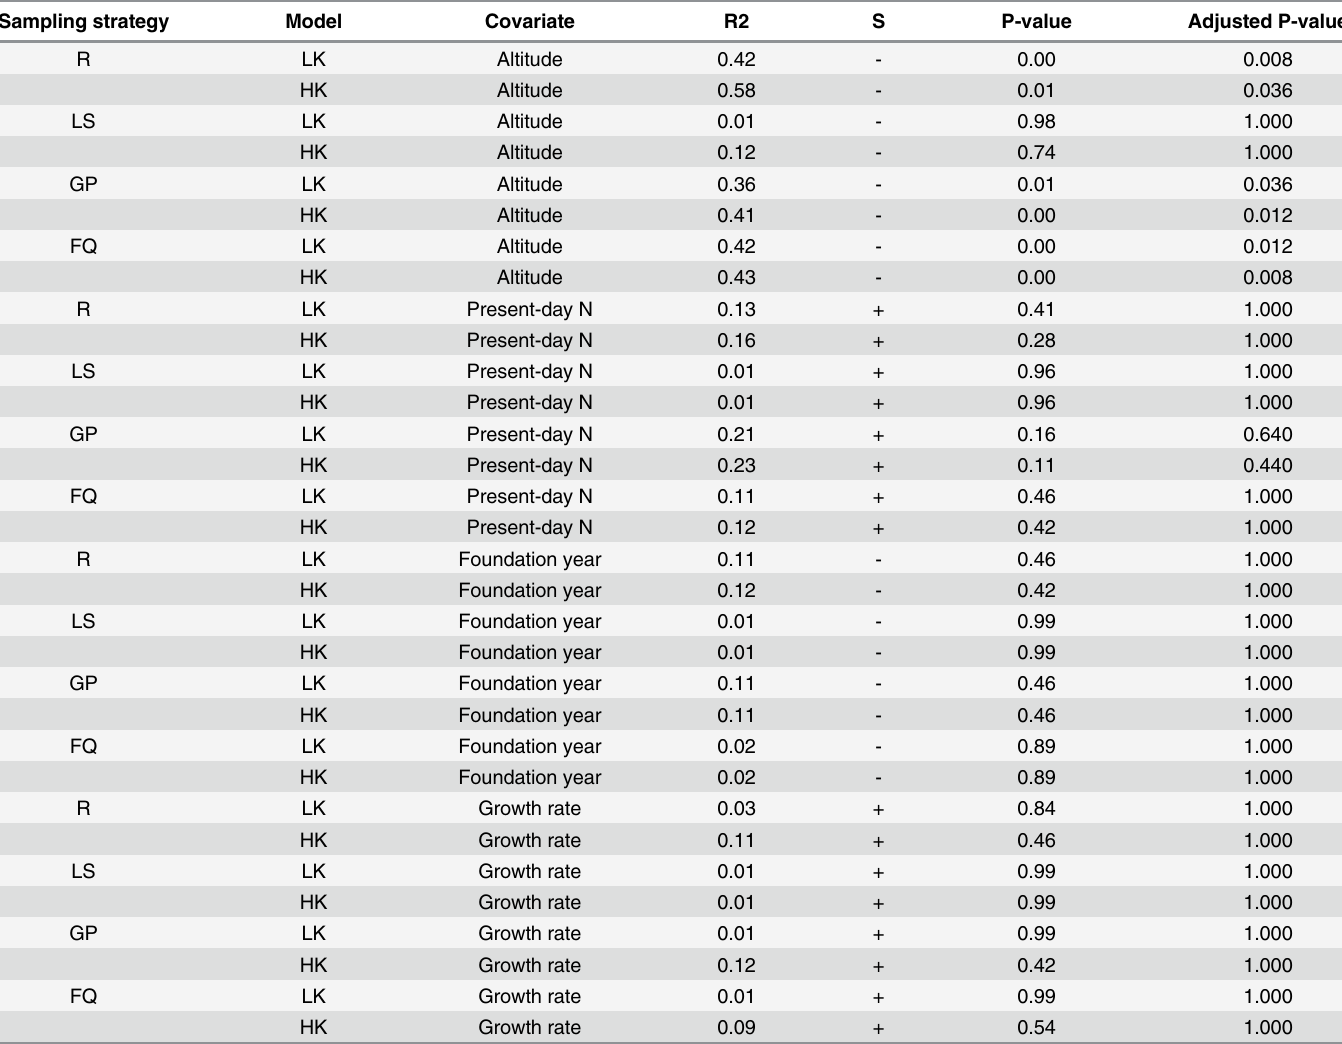
Table 2. Detailed list of R2 values and correlation signs (S) with nominal and Bonferroni adjusted P-values for different sampling strategies and models. Sampling strategies: R, random; FQ, first quartile; LS, locally spread; GP, grandparents; FS, founder surnames. Models: LK, low-kinship; HK, high- kinship. Sampling